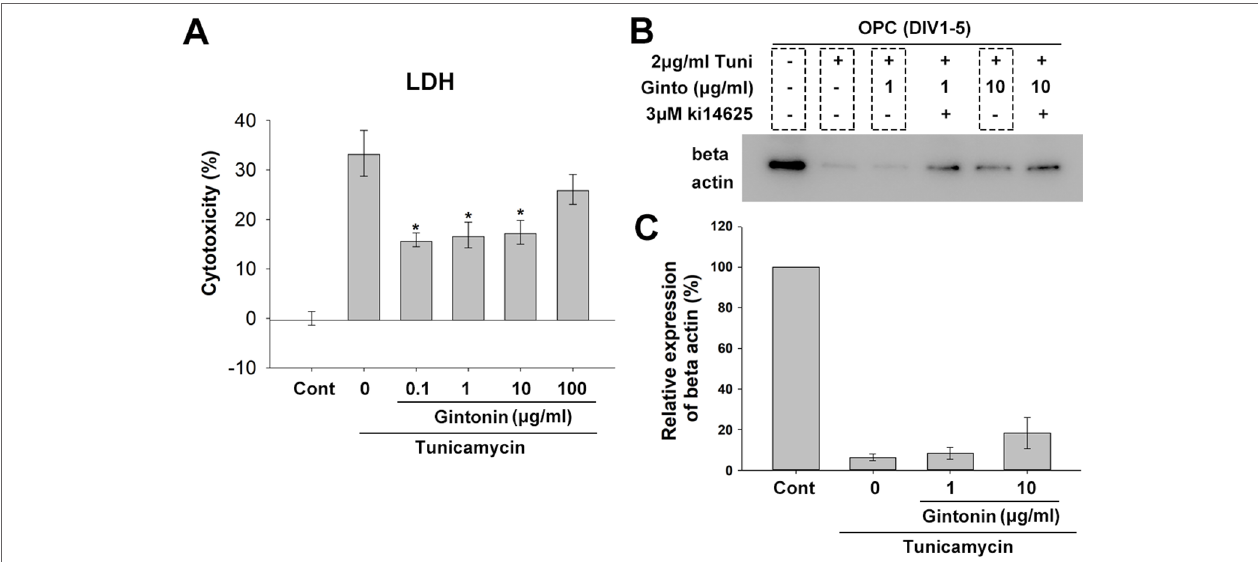
FIGURE 5 | Gintonin protects oligodendrocyte lineage cells against ER stress-induced cytotoxicity. (A) Oligodendrocyte precursor cell (OPC) cultures were treated with gintonin of various concentrations (0.1, 1, 10, 100 μ g/ml) under 5 μg/ml tunicamycin during DIV 1–2 and LDH assay was performed at DIV2 (* p < 0.05, N = 3). (B , C) OPC cultures were exposed to long term ER stress induced by tunicamycin during DIV1–5 with or without gintonin or LPA inhibitors of indicated concentrations and submitted to Western blot analysis (B) and the expression quantification of beta actin was performed (C) . Bars represent mean ±